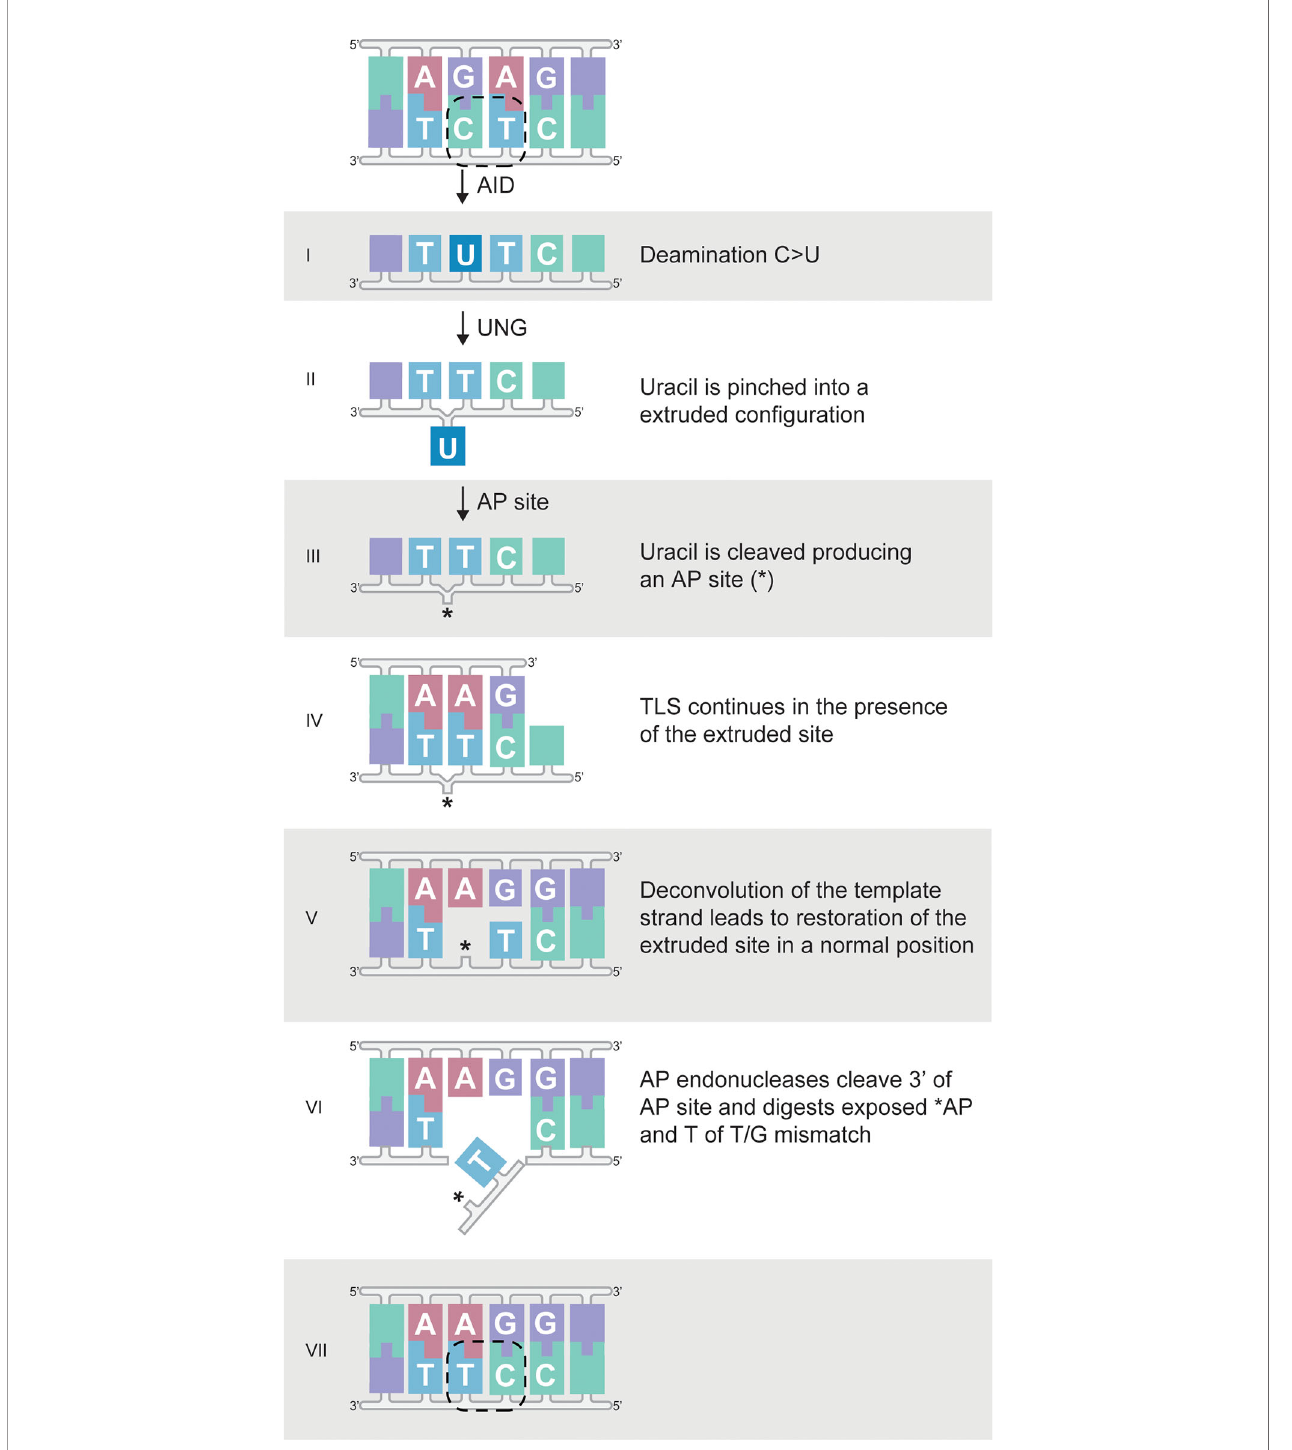
FIGURE 8 | Proposed EXPEDITE model for tandem substitutions causing juxtalocation of adjacent residues during DNA replication. (I) Cytosine (C) is deaminated to uracil (U) in a polypyrimidine context (shown here as an example since this context typically contains the most tandem substitutions, refer to ). (II) UNG pinches the U into an extruded con fi guration and (III) U is cleaved, leaving an AP site (*). (IV) If during DNA replication the resulting extruded AP site is tolerated, the juxtaposed base acts transiently as a substitute template. (V) After decontraction of the template strand, the AP site is reverted to a normal con fi guration and replication continues from the ‘ mismatch ’ position containing the AP site. (VI) Hereafter, the AP site, as well as the mismatch, is removed by canonical base excision repair. (see Discussion ). (VII) Final repair synthesis and